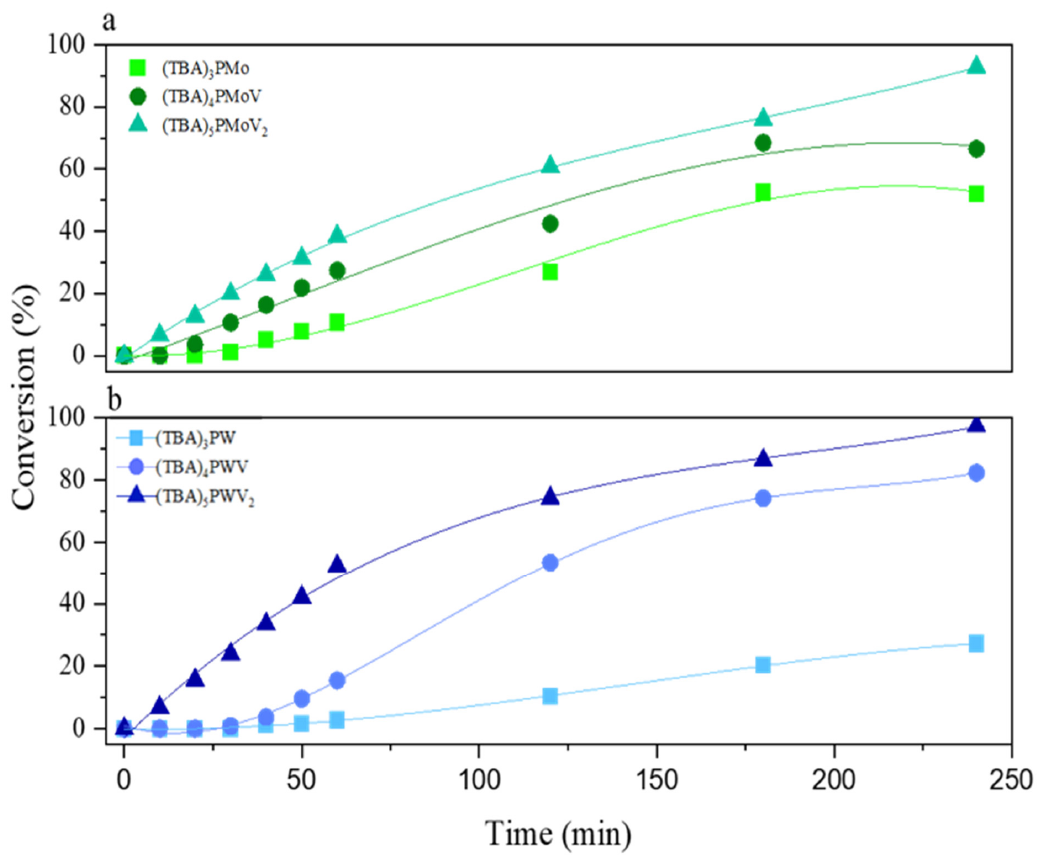
Figure A2. Total conversion (%) of the liquid-phase aerobic oxidation of benzyl alcohol over time for the pure and substituted Mo ( a ) and W ( b ) catalysts.